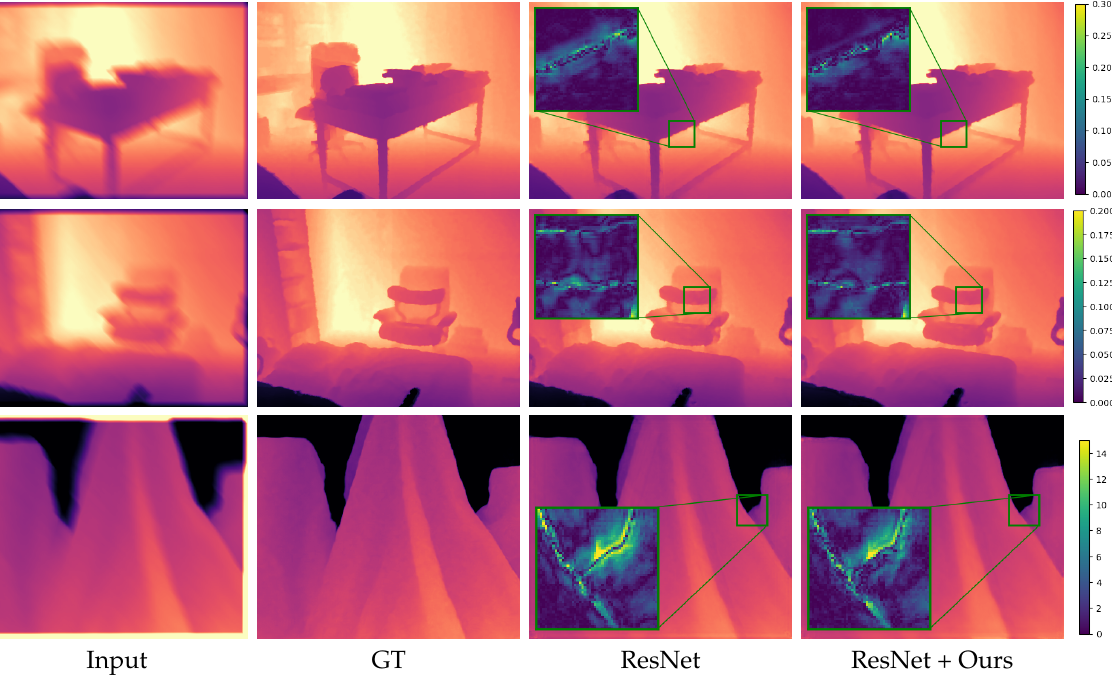
Figure 3. Deblurring results. Insets show absolute difference to ground truth. The first two rows are examples from the NYU v2 [33] test set and the third row from the Middlebury dataset